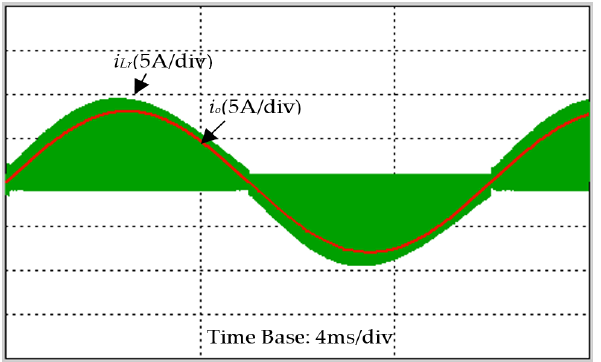
Figure 17. Simulation waveforms of the auxiliary current with an 8 A, 100 Hz sinusoidal output current.